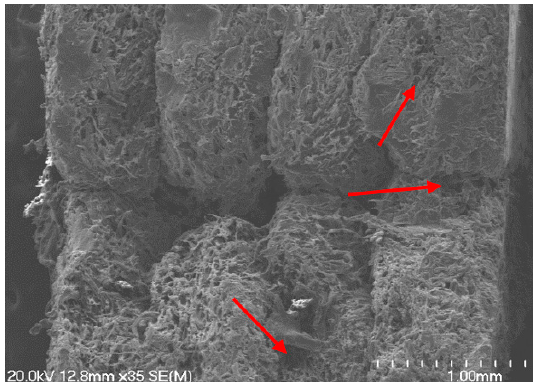
Figure 18. Porous surface of a 30 wt % hemp dog bone sample at comparatively lower magnification also showing large gaps between layers of printed material (layers are horizontal).